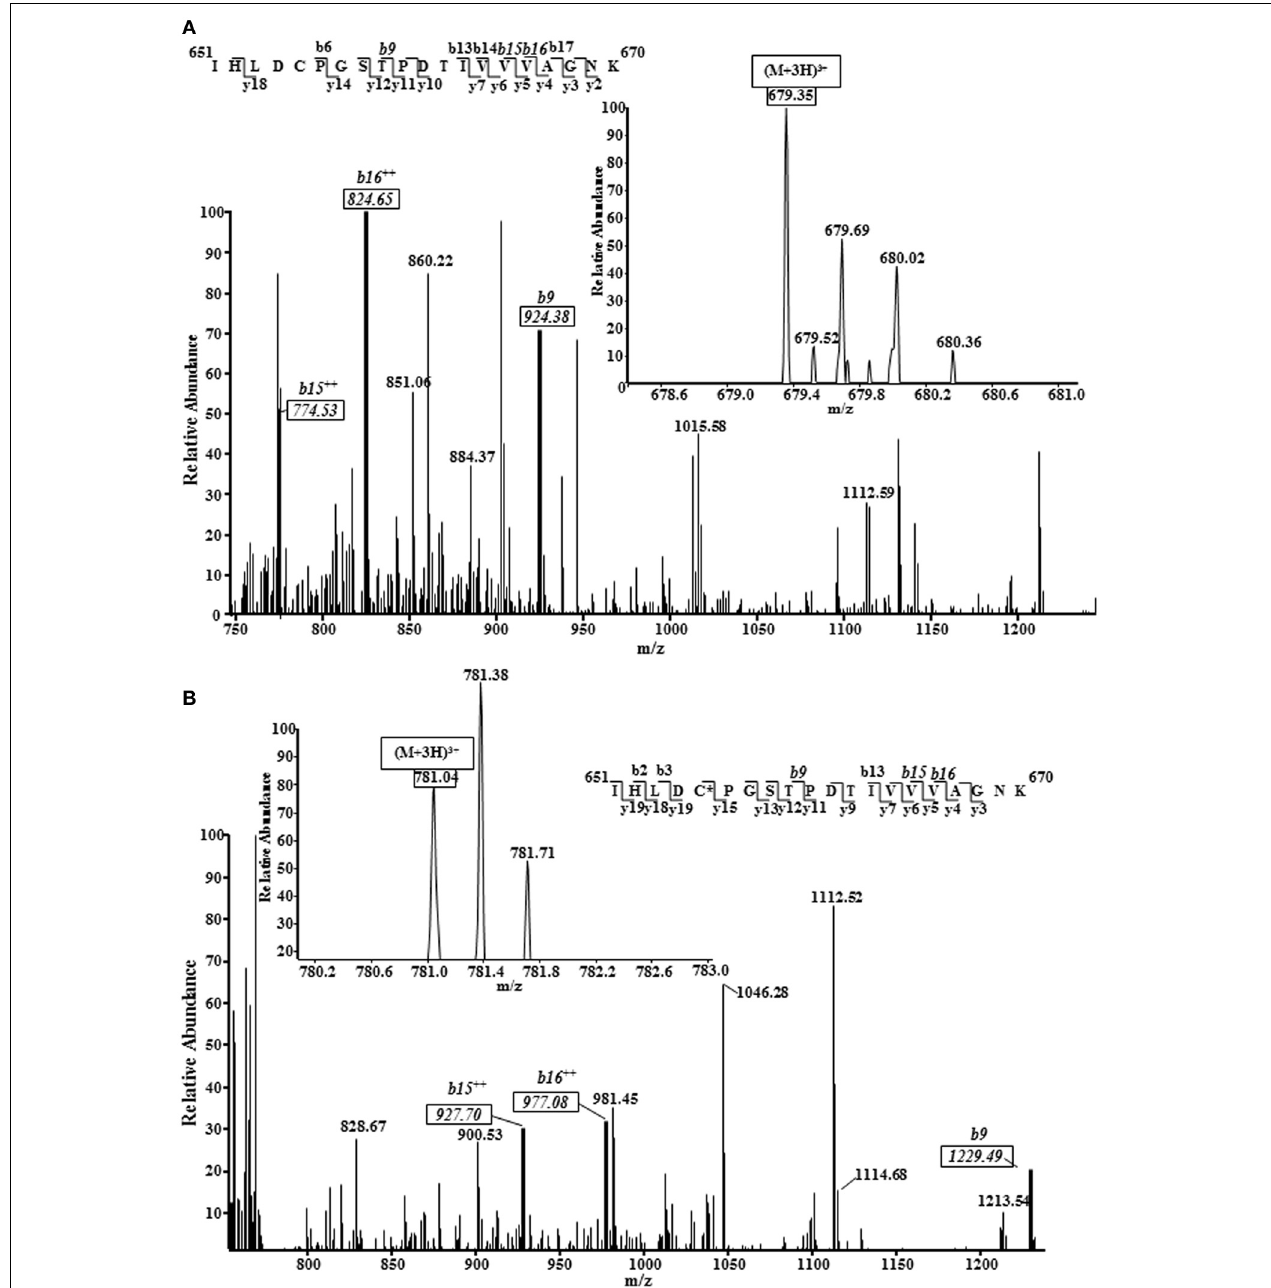
FIGURE 5 | Representative mass spectra (MS) and tandem mass spectra (MS/MS) of a triply protonated cMyBP-C peptide ( 651 IHLDCPGSTPDTIVVVAGNK 670 ) showing Cys 655 glutathionylation. 1mM GSSG treated myofibrils subjected to mass spectrometry analysis revealed cysteine 655 of the C5 domain of mouse cardiac myosin binding protein C as a target for S-glutathionylation. The same site, along with 2 other sites, was also identified in 5mM GSSG treated myofibrils. (A), MS/MS of unmodified peptide showing several key b ions (solid boxes); inset figure